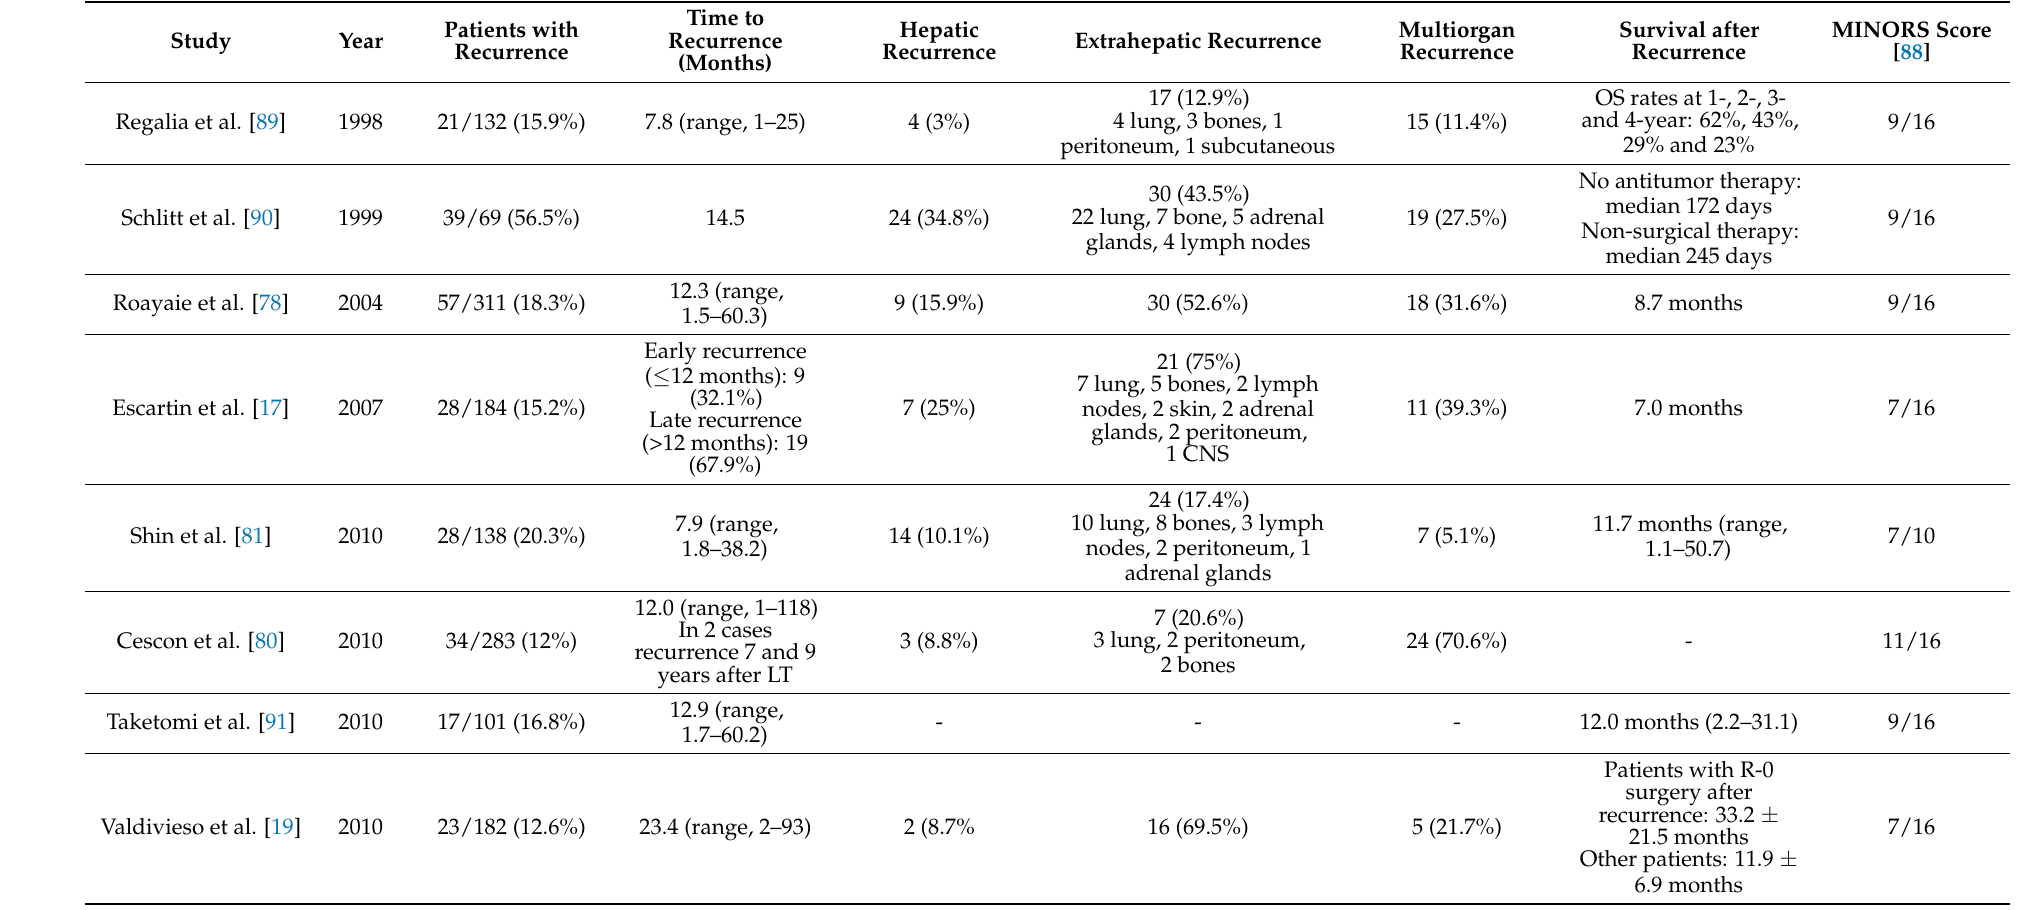
Table 4. Studies investigating the pattern of HCC